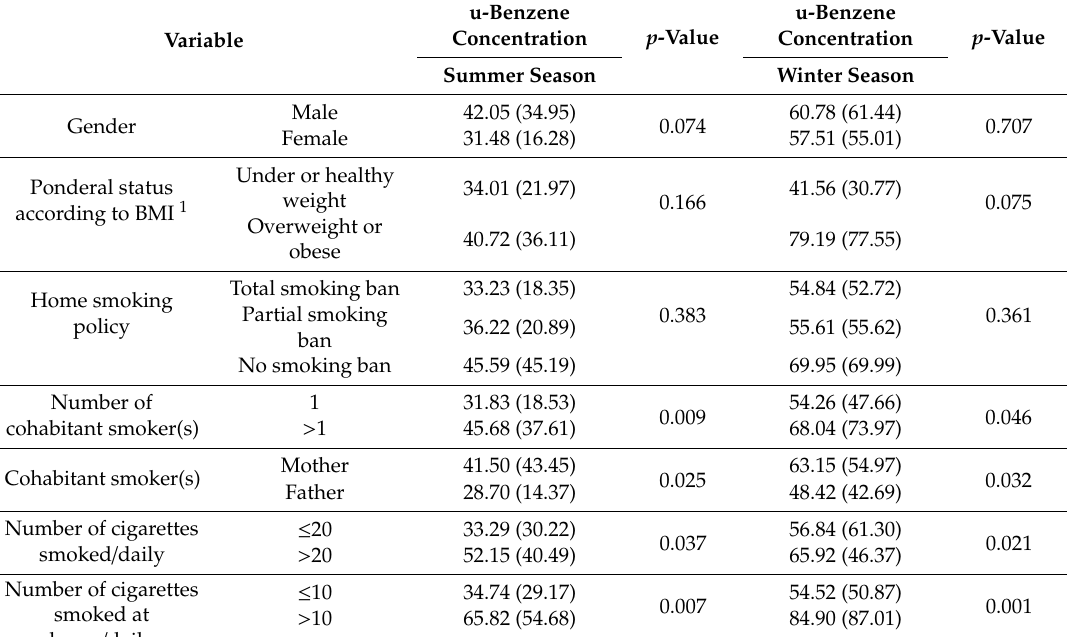
Table4. u-Benzeneconcentrations (ngL − 1 )accordingto homesmoking habitsof participants’cohabitant smoker(s), just considering the group of children exposed to environmental tobacco smoke